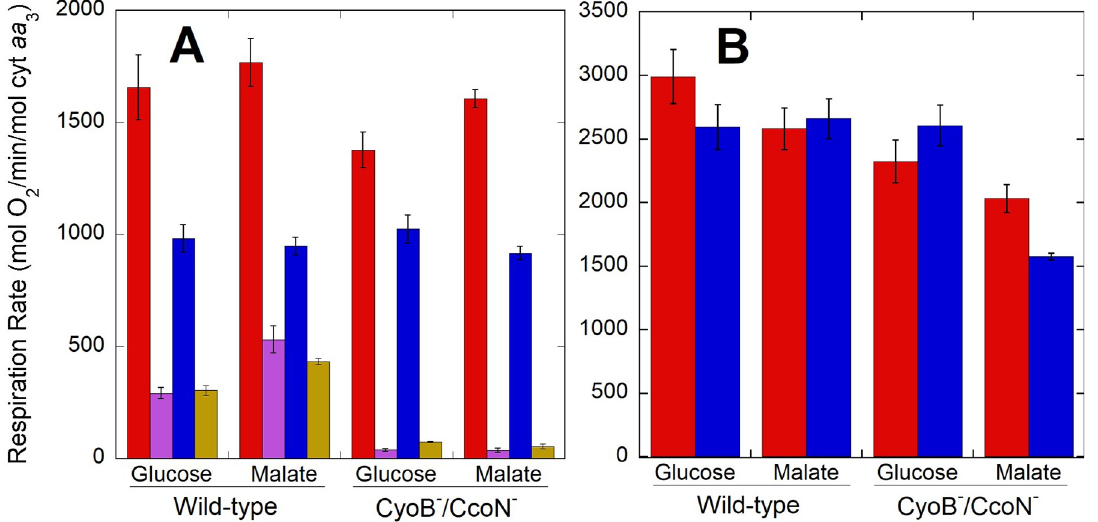
Fig 1. Respiration rates of wild-type and CyoB - /CcoN - cells adapted to growth in glucose or malate. Oxygen consumption rates were collected in growth medium in the absence (red) or presence (magenta) of 10 μ M antimycin, and in depletion buffer containing no NH 4+ in the absence (blue) or presence (gold) of 10 μ M antimycin. Panel A shows normal coupled respiration rates, whereas panel B shows maximal rates obtained after addition of 0.25–0.5 μ M of the uncoupler DBNP. Bars correspond to the average ± standard error of 3–8 independent determinations for each strain and